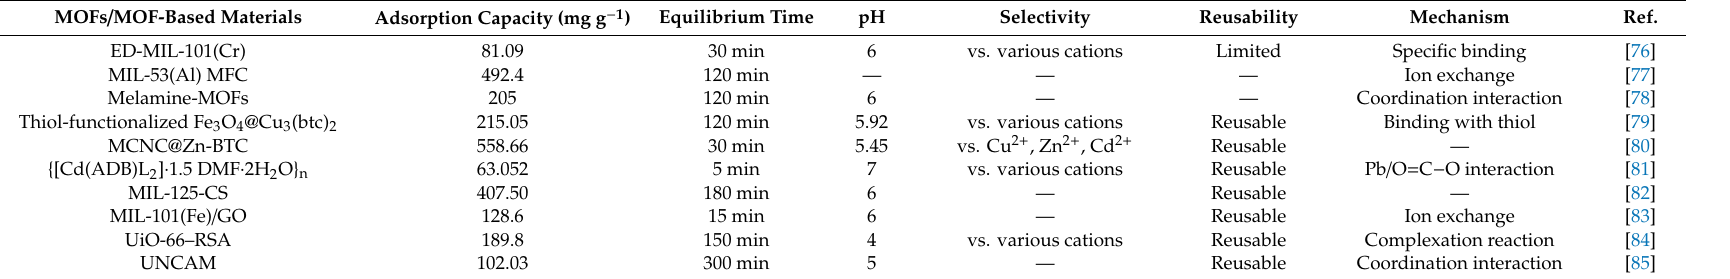
Table 4. Lead adsorption data for the reported MOFs and MOF-based materials.